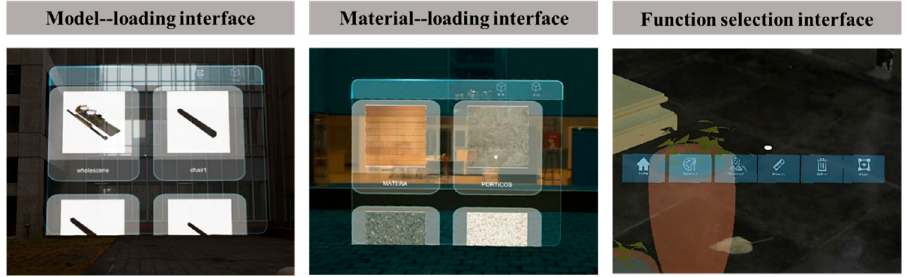
Figure 2. The interactive interfaces of HoloDesigner.